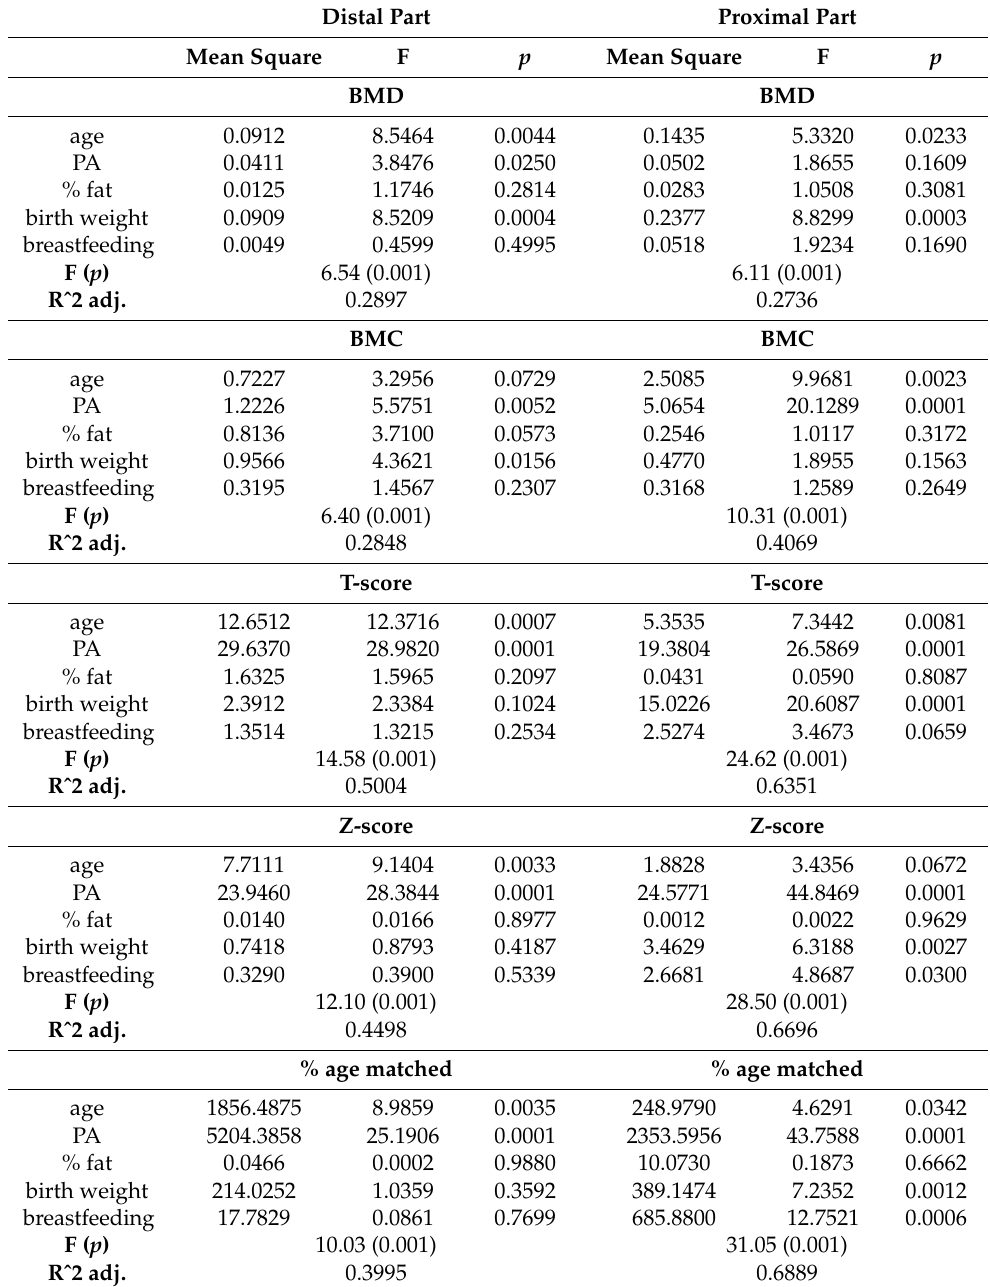
Table 3. The strength of relationships of major determinants of biological bone mineralization status with all bone parameters (results of ANCOVA analyses, age-continuous